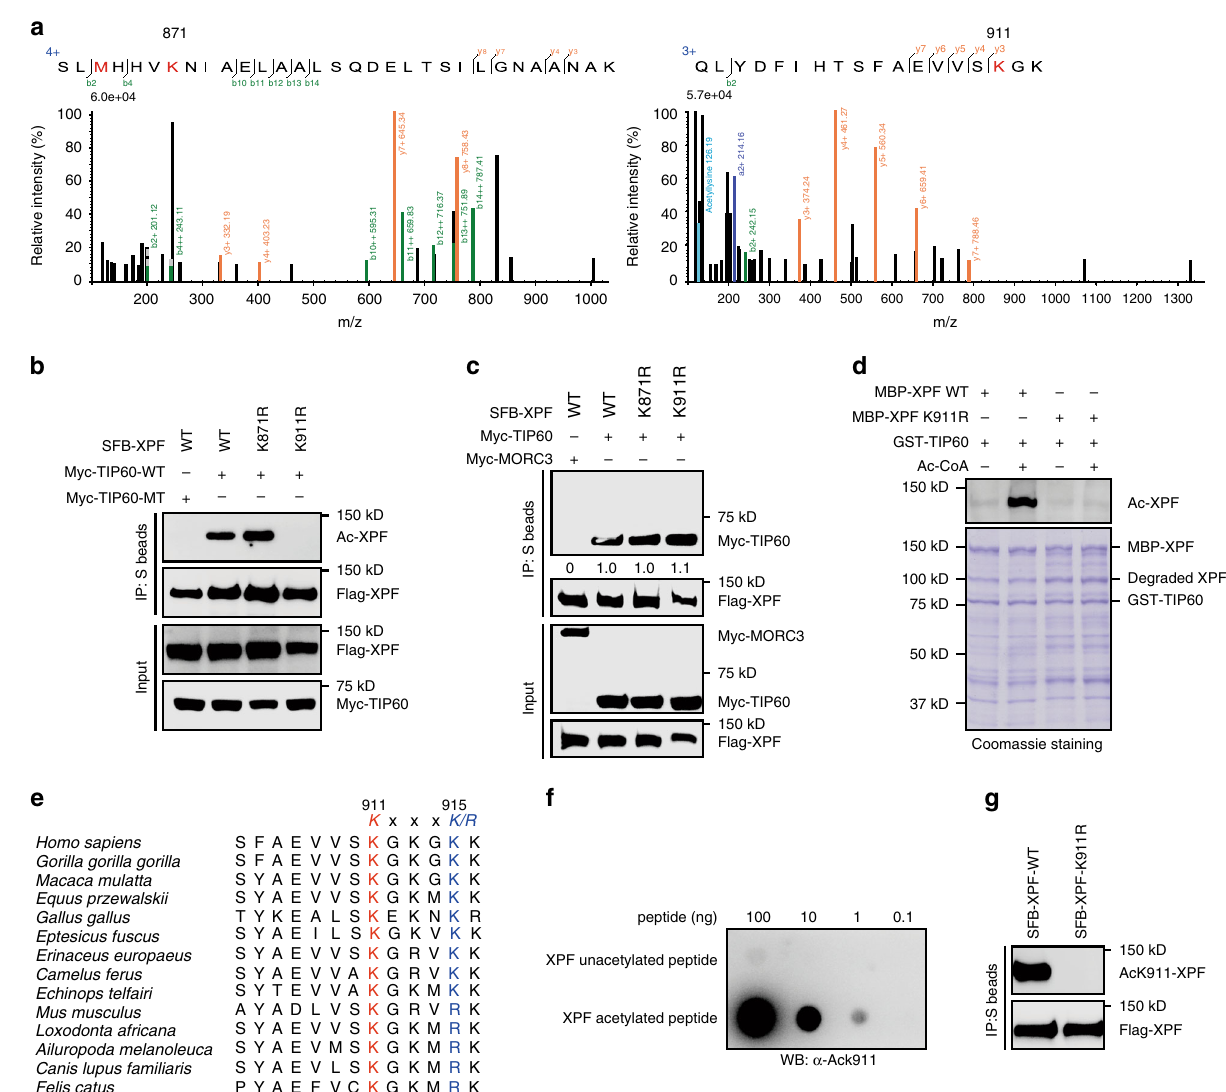
Fig. 3 TIP60 acetylates XPF at lysine 911. a XPF acetylation was analyzed by mass spectrometry. HEK293T cells stably expressing SFB-tagged XPF were treated with Nicotinamide (10 mM) and TSA (10 μ M) for 4 h. SFB-XPF was then puri fi ed and subjected to MS analysis (the mass tolerance is 20 ppm). b TIP60 acetylates XPF at K911 in vivo. HEK293T cells were transiently transfected with the indicated plasmids for 24 h. Whole-cell lysates were then prepared and subjected to immunoprecipitation with S beads and western blot analysis was carried out as indicated. c HEK293T cells were transiently transfected with the indicated plasmids for 24 h. Whole-cell lysates were then immunoprecipitated with S beads, and western blot analysis was carried out as indicated. The amount of co-immunoprecipitated TIP60 was quanti fi ed by ImageJ, normalized to total immunoprecipitated XPF, and shown below the blot. d TIP60 acetylates XPF at K911 in vitro. Wild-type XPF or the K911R mutant puri fi ed from E. Coli were incubated with recombinant TIP60 protein in reaction buffer in the presence or absence of the acetyl-CoA (2 mM) at 37 °C for 30 min. Upper panel: XPF acetylation was detected by immunoblotting. Lower panel: Puri fi ed proteins were resolved by SDS-PAGE and visualized by Coomassie blue staining. e Sequence alignment of the region containing the acetylation site in XPF from different species. f Characterization of the anti-AcK911-XPF antibody by a dot blot assay. Various amounts of unacetylated or acetylated XPF-K911 peptides were spotted onto nitrocellulose membrane and immunoblotted with the anti-AcK911-XPF antibody. g HEK293T cells were transfected with the indicated plasmids for 24 h. Whole-cell lysates were then incubated with S beads and western blot analysis was carried out as indicated. Source data are provided as a Source Data fi